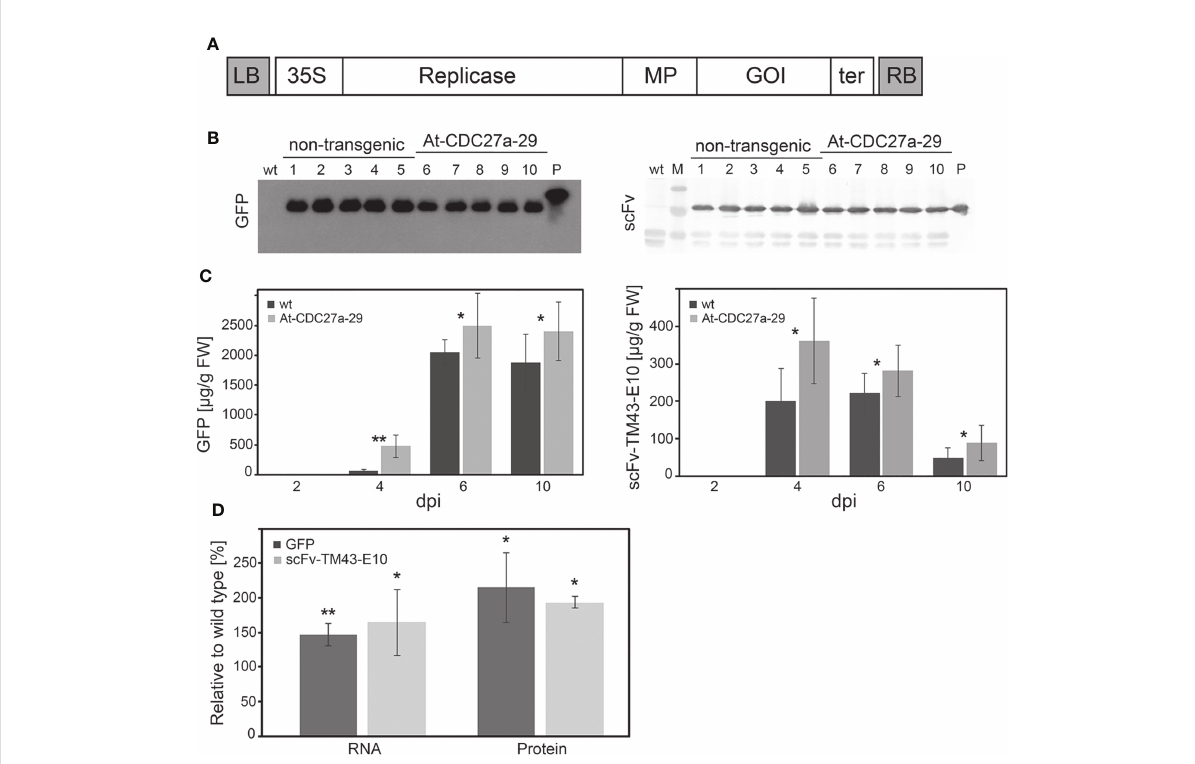
FIGURE 5 Transient production of recombinant proteins. (A) Schematic diagram of the TRBO expression vector. Open boxes represent the following sequences: 35S, CaMV 35S promoter; Replicase, RNA-dependent RNA polymerase; MP, 30 kDa protein involved in virus movement; GOI, gene of interest (GFP, scFv-TM43-E10); ter, 3 ’ terminator sequence; LB, RB, left and right border of T-DNA, respectively. (B) Western blot analysis of GFP and scFv-TM43-E10 accumulation. The leaf samples were collected from the At-CDC27a-29 and non-transgenic N. benthamiana plants agroin fi ltrated with the TRBO- GFP and TRBO- scFv-TM43-E10 expression constructs at 6 dpi. Six and one µg of total proteins for scFv-TM43- E10 and GFP plant extracts, respectively, were separated on 12% SDS-PAGE and analysed for the presence of scFv-TM43-E10 and GFP proteins by immunoblot. Lanes: 1-5, total protein extracts from the agroin fi ltrated non-transgenic leaf material; 6-10, total protein extracts from the agroin fi ltrated At-CDC27a-29 leaf material. P: GFP with His Tag (Biozol, Eching, Germany) and scFv-TM43-E10 (protein preparation extracted from E coli ) control proteins. Wt: total protein extract from the non-agroin fi ltrated wild type N. benthamiana plant. M: PageRuler Prestained Protein Ladder (Thermo Scienti fi c, Waltham, USA). (C) Time course analysis of GFP and scFv-TM43-E10 production. Leaf samples of the At- CDC27a-29 and non-transgenic plants agroin fi ltrated with the TRBO- GFP and TRBO- scFv-TM43-E10 expression vectors were collected on 2, 4, 6 and 10 dpi and subjected to ELISA to estimate protein accumulation. Each sample is a pooled sample generated by combining three in fi ltrated spots from middle leaves of one plant. For each time point 6 and 10 samples for GFP and scFv-TM43-E10, respectively, are shown. Values represent the means with standard deviation. (D) Quanti fi cation of RNA and protein levels of GFP and scFv-TM43-E10. Total RNA and soluble proteins from the At-CDC27a-29 and wild type agroin fi ltrated leaves were extracted at 4 dpi and investigated by qRT-PCR and ELISA to estimate RNA and protein accumulation, respectively. For RNA quanti fi cation 10 samples were evaluated for each variant (wt and At-CDC27a-29 plants). For protein quanti fi cation 6 and 8 samples for GFP and scFv-TM43-E10, respectively, were analysed. Each sample is a pooled sample generated by combining three in fi ltrated spots from middle leaves of one plant. The values are expressed as a percent relative to the wild type and represent the means with standard deviation. Asterisks indicate signi fi cance as determined by the Mann-Whitney test, with *and ** denoting p < 0.05 and p < 0.01,